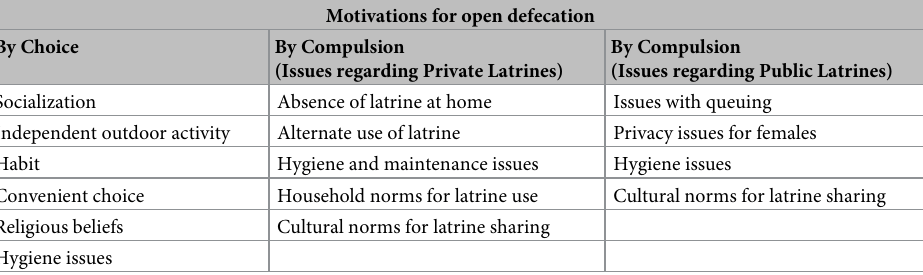
Table 2. Summary of the motivators for open